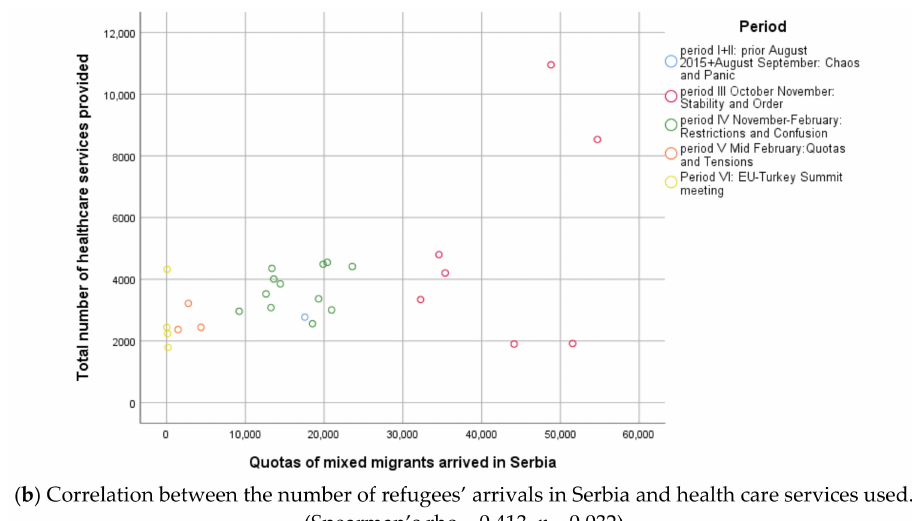
Figure 2. The number of refugees’ arrivals in Serbia, their medical conditions ( a ) and health care services utilisation ( b ) during the Western Balkan Refugee Crises 2015 /